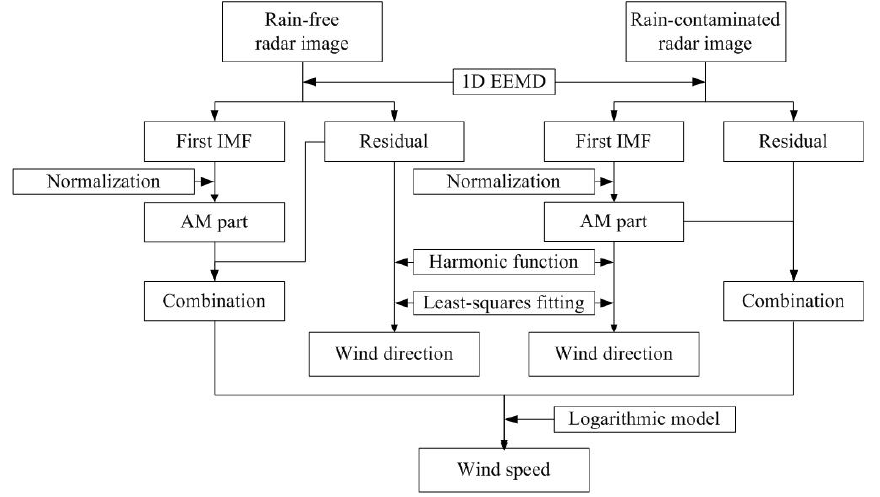
Figure 6. Basic steps of the ensemble empirical mode decomposition (EEMD)-normalization-based